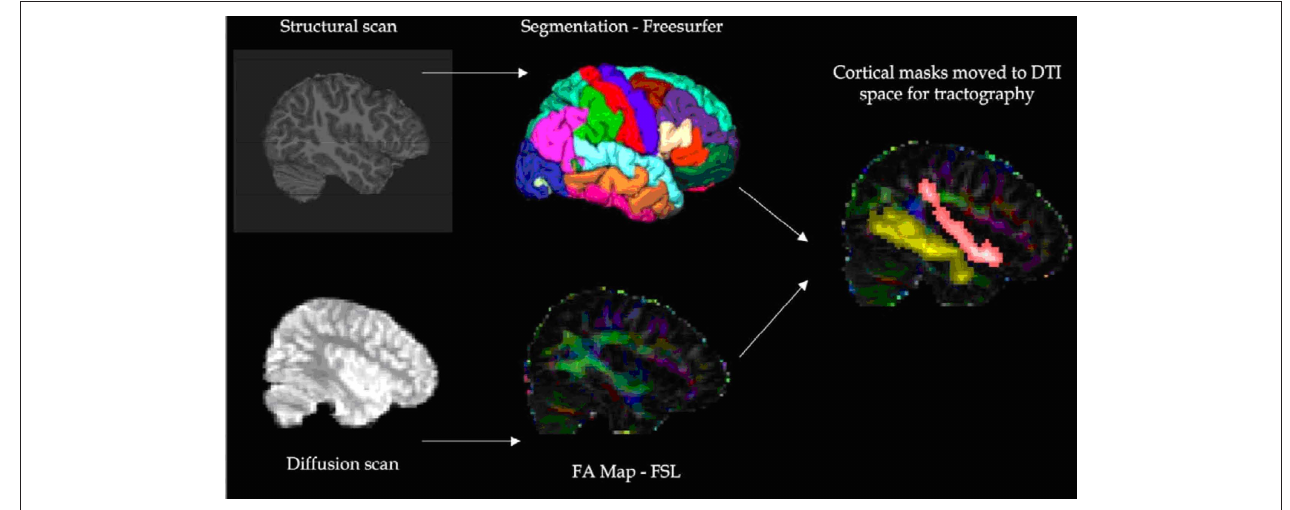
FiguRe 1 | Procedure used for imaging analysis.